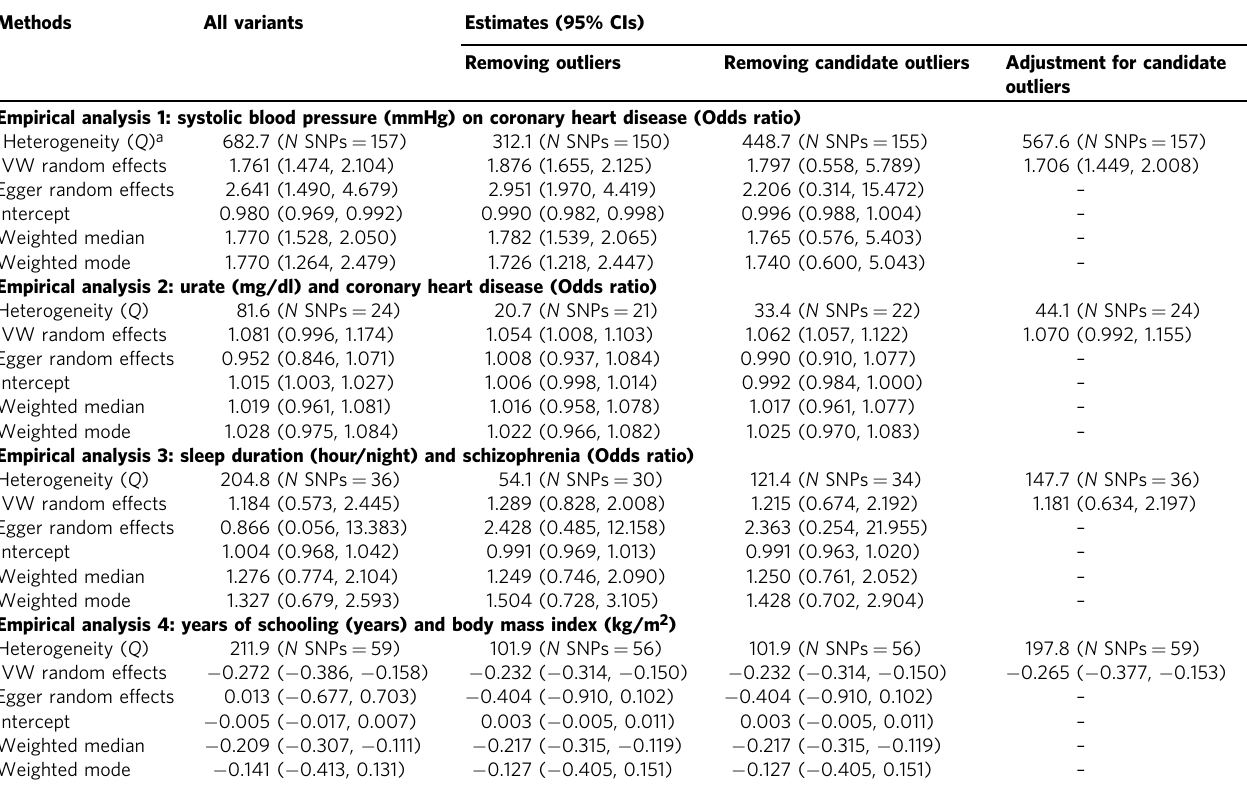
Table 2 Results of empirical analyses with different IV estimators derived from various MR